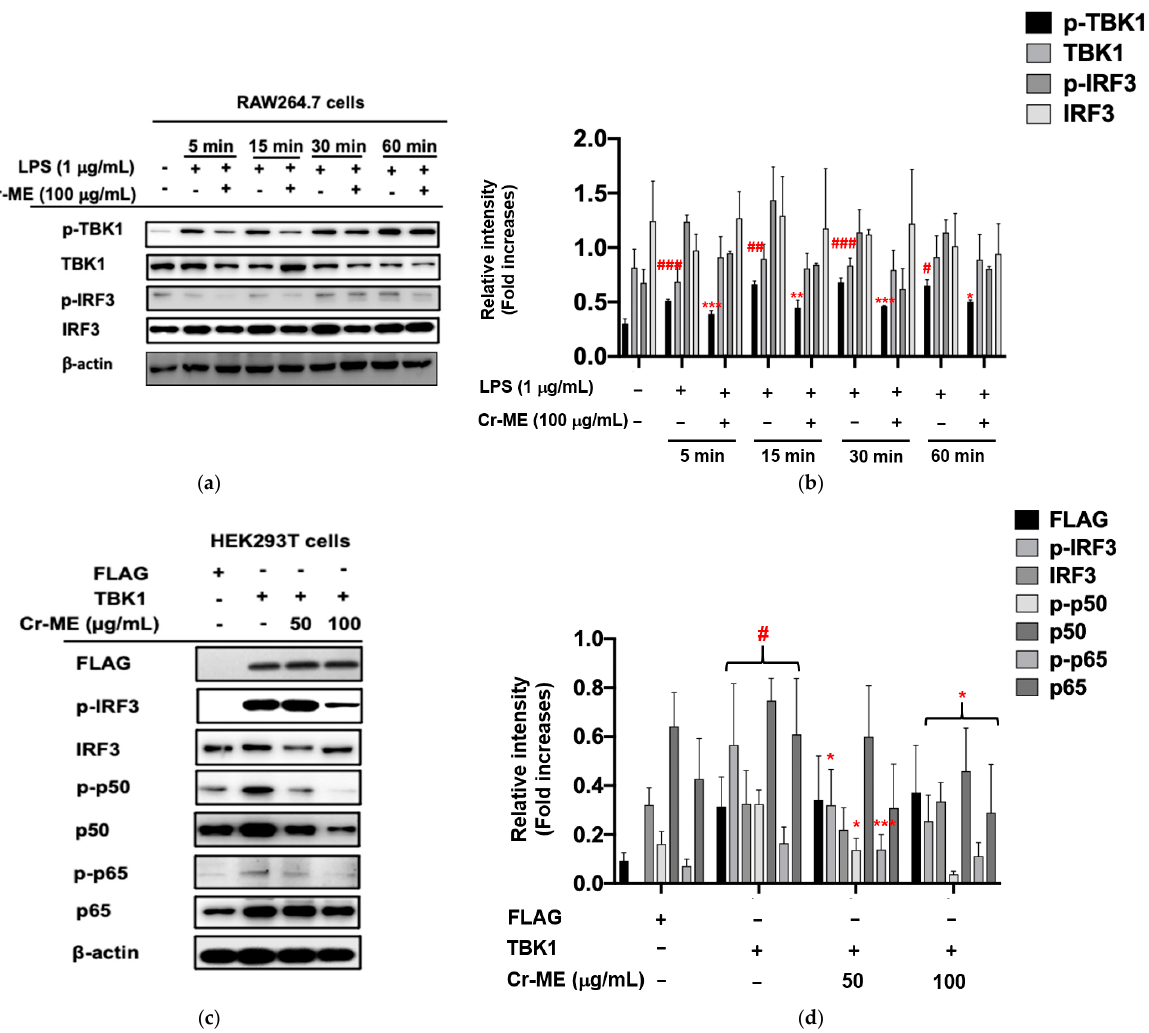
Figure 4. Effect of Cr-ME on the IRF3 pathway and its upstream enzyme TBK1 activation. ( a , b ) RAW264.7 cells pretreated with 100 µ g/mL of Cr-ME were stimulated by LPS (1 µ g/mL) for the indicated times. Then, the phosphorylation levels